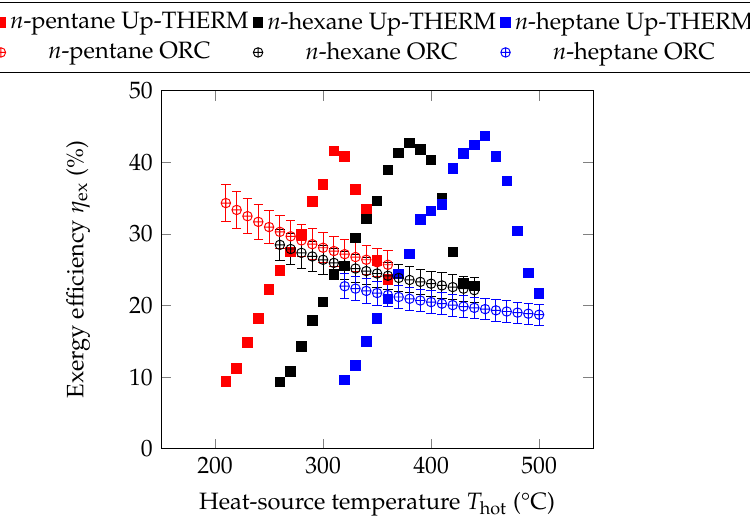
Figure 6. Exergy efficiency of the Up-THERM heat converter and equivalent ORC engines for different working fluids at different heat-source temperatures. For the ORC engines, the circles indicate an expander isentropic efficiency of 0.70 and the error bars isentropic efficiencies of 0.65 and 0.75,